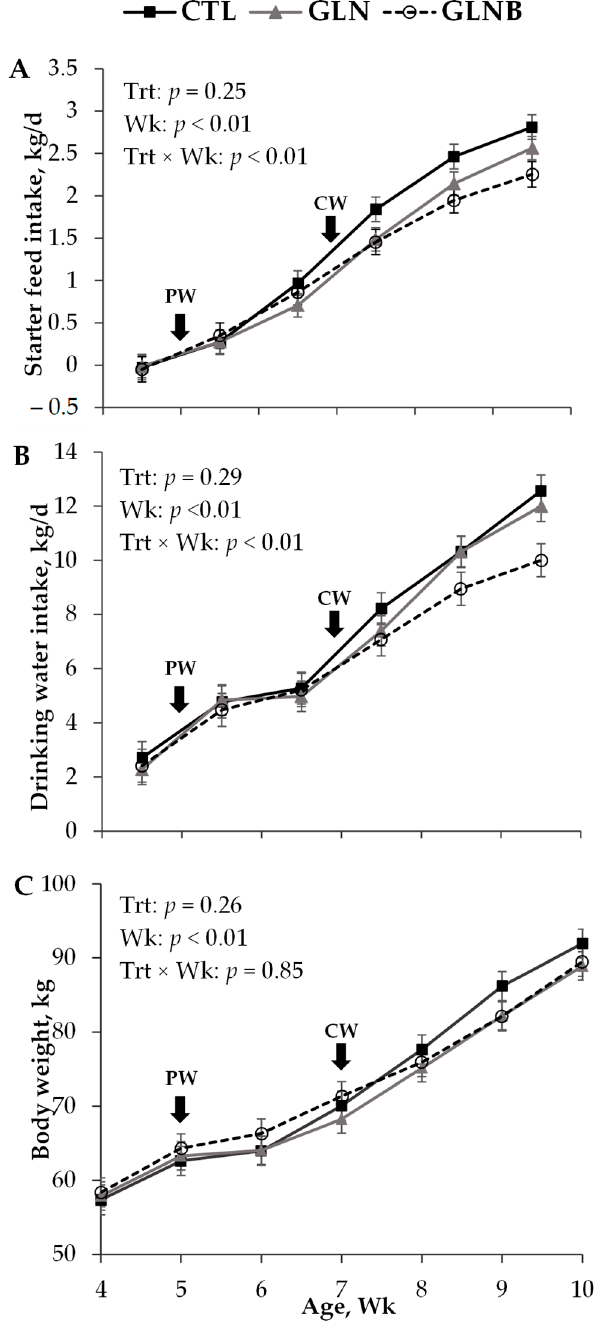
Figure 1. Weekly (Wk) mean (± SEM) starter feed intake ( A ), drinking water intake ( B ) and body weight ( C ) of calves undergoing a stepdown weaning scheme without AA supplementation (CTL), and with Gln alone (GLN) or Gln and branched-chain amino acid (GLNB) supplementations (n = 11) as treatments (Trt). PW = the initiation of stepdown weaning by restricting the milk allowance from 9.0 to 3.0 kg/d at 35 d of age, CW = complete weaning as starter intake approached 1.0 kg/d.